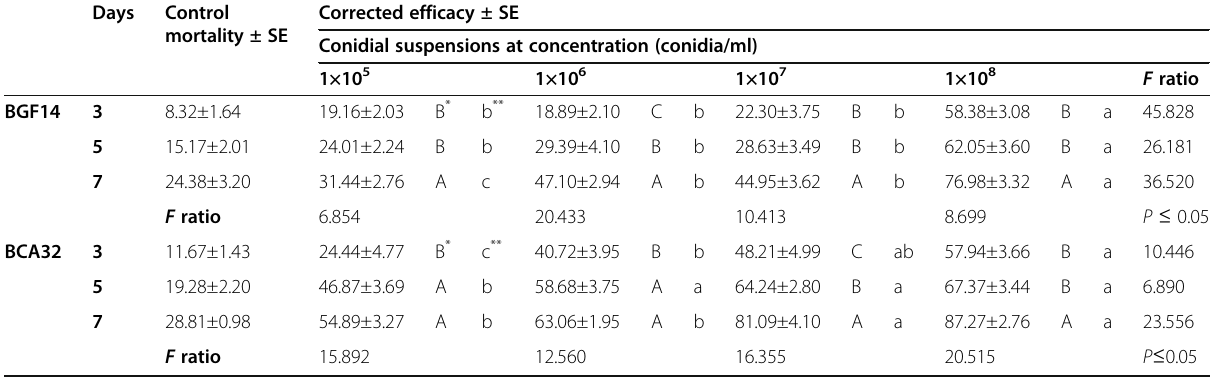
Table 1 Corrected mortality of BGF14 and BCA32 isolates of Beauveria bassiana against Tetranychus urticae adults Days Control Corrected efficacy ± SE mortality ± SE Conidial suspensions at concentration (conidia/ml)